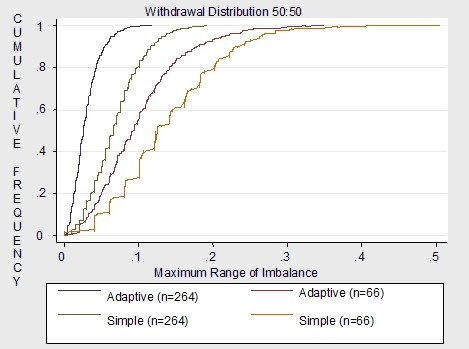
Non-stratifying factors: stratified simple vs. adaptive (5 covariates) for n = 66 and n = 264.